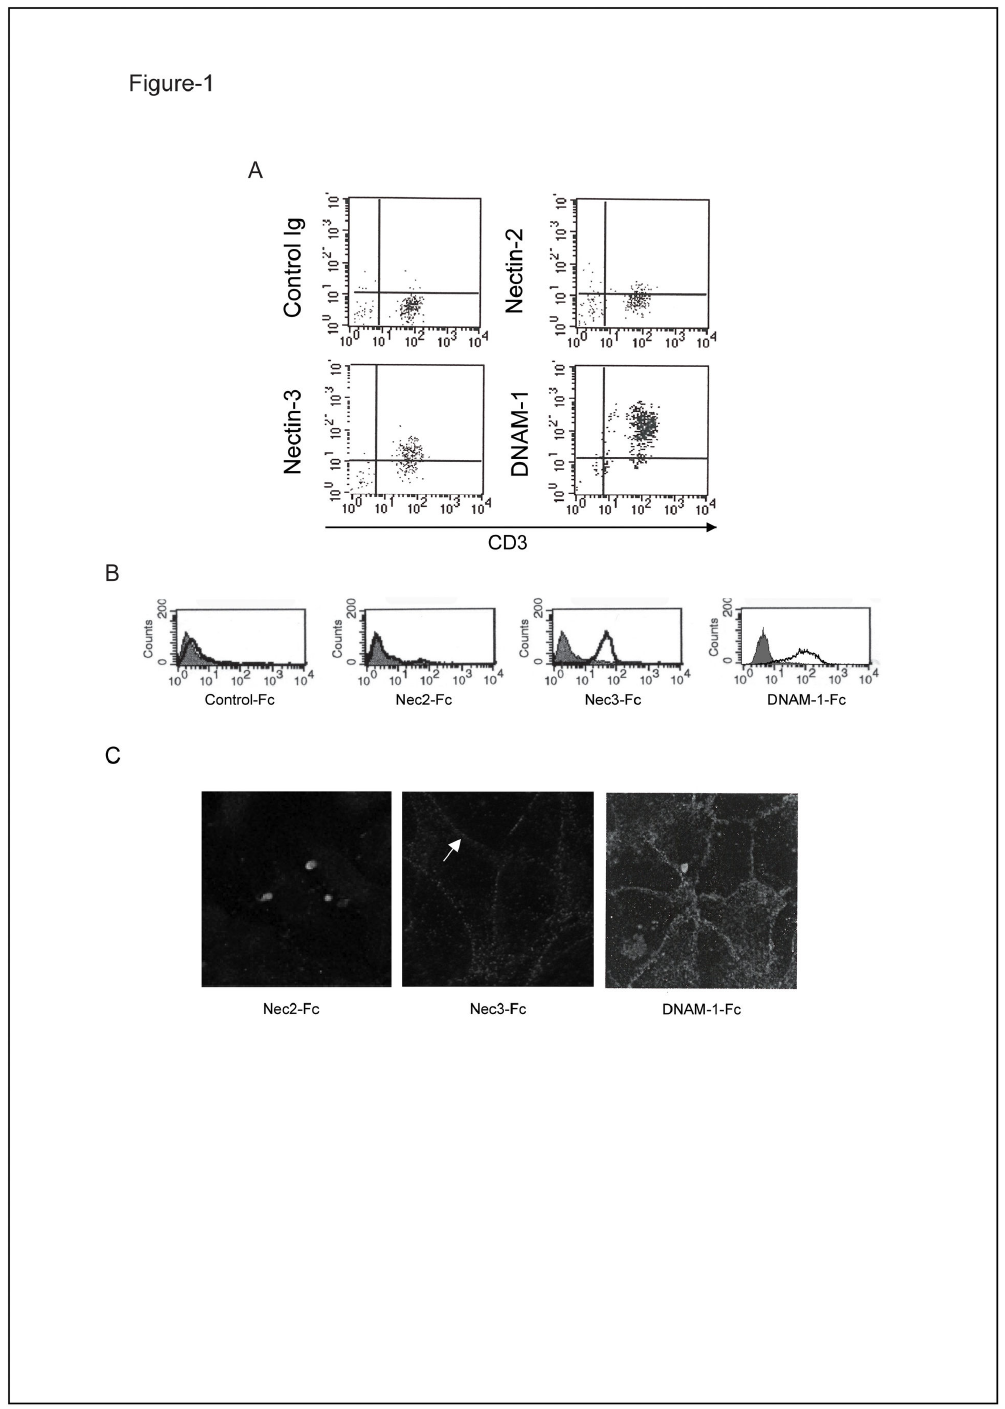
Figure 1. Nectin-3 is expressed on T-lymphocytes and binds to a junctional ligand on ECs. A : Fresh PBMCs were gated on lymphocytes on the basis of both size and granularity. Cells were analyzed by two color-immunofluorescence and cytometry with anti-CD3 in combination with anti-Nectin-2 (R2.477), anti-Nectin-3 (N3.12) and anti-DNAM-1 (FS123) mAbs. DNAM-1, previously described to be expressed on T-cells, was taken as a positive control [51]. B : Binding of soluble Nectins and DNAM-1 to HUVECs was analyzed by FACS as indicated. C : Binding of soluble Nectins and DNAM-1 to HUVECs was analyzed by one color- immunofluorescence as indicated. Bold arrows show junctional stainings. Bar, 50 µm. doi: 10.1371/journal.pone.0077424.g001 PLOS ONE |